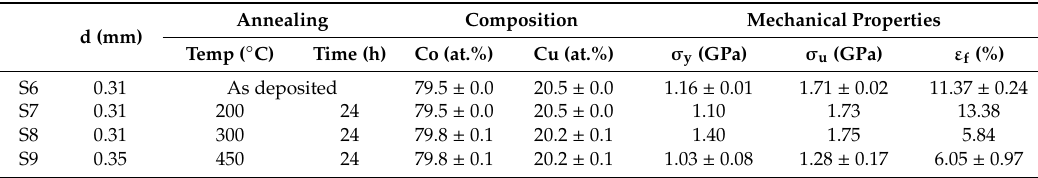
Figure 7e depicts engineering tensile stress vs. strain curves of S6–S9 at a strain rate of 1.0 × 10 − 3 s − 1 and the detailed data are provided in Table 3. The stress vs. strain curve of S6 confirms that the as deposited state shows good ductility, with a total elongation at fracture of 11.37 ± 0.24%. In comparison with S6, annealing at 200 °C for 24 h (S7) leads on the improvement of ductility while the strength is maintained at the same level (see Figure 7e and Table 3). Surface morphology images at a